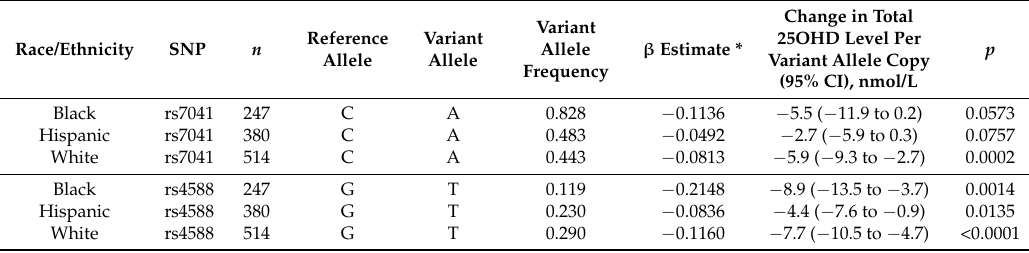
Table 2. Association of vitamin D-binding protein genetic polymorphisms and serum 25OHD levels by race/ethnicity.